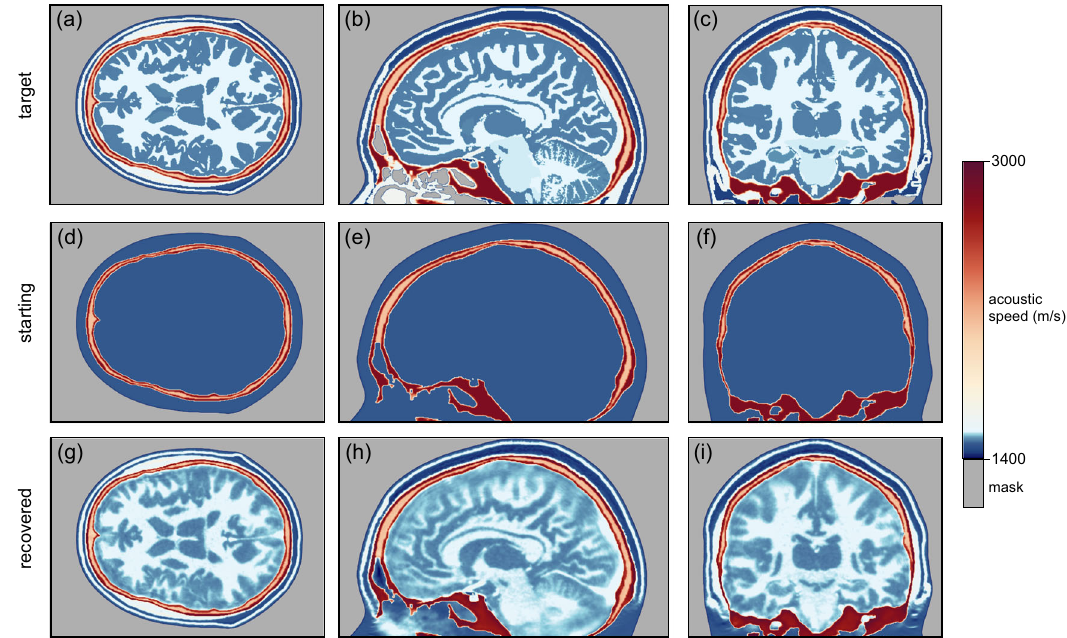
Fig. 3 Models of acoustic wave speed. Transverse (left), sagittal (centre), and coronal (right) sections through the true (top), starting (middle), and recovered (bottom) models. Both the wave fi eld modelling and waveform inversion are performed in three dimensions. The starting model includes the true model of the skull, but is otherwise